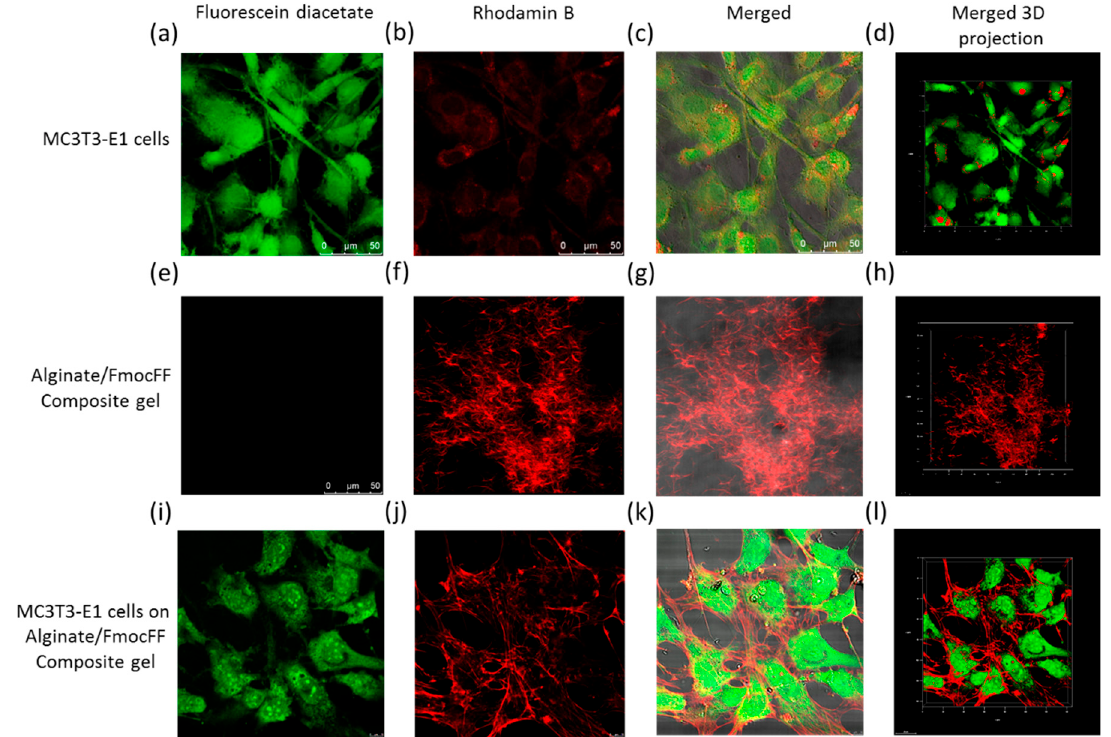
Figure 3. MC3T3-E1 cell viability and spreading onto Alginate/FmocFF composite hydrogel. ( a – d ) Control MC3T3-E1 cells stained with fluorescein diacetate and rhodamin B after 3 days of culture on a plate. ( e – h ) control Alginate/FmocFF hydrogel stained with fluorescein diacetate and rhodamin B. ( i – l ) MC3T3-E1 cells cultured for 3 days on Alginate/FmocFF composite hydrogel and stained with